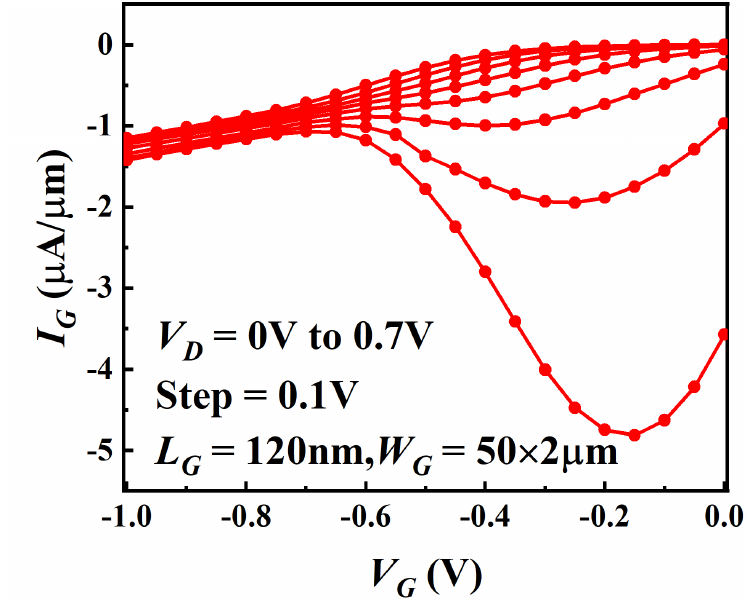
Figure 7. Gate current leakage characteristic of the InGaAs HEMTs on Si